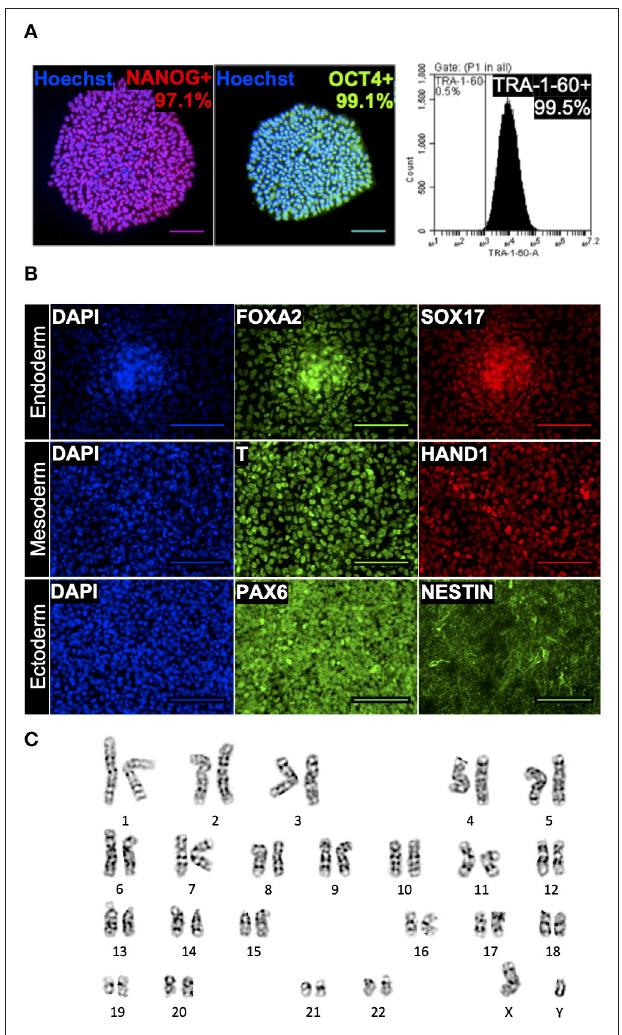
FIGURE 3 | Immunocytochemistry of human induced pluripotent stem cells (hiPSCs) cryopreserved using the optimized dimethyl sulfoxide (DMSO)-free solution. Monochromatic images with pseudo-coloring matching the real color of respective fluorescent dye. (A) Quantitative fluorescent microscopy (counterstained with nuclear dye Hoechst 33342, blue) and forward vs. side scatter-gated flow cytometry of cryopreserved hiPSCs showing high expression of transcription factors NANOG (red), OCT4 (green), and pluripotency surface marker TRA-1-60. Scale bar: 100 µ m. (B) Immunocytochemistry images showing trilineage differentiation of cryopreserved hiPSCs into three germ layers and expression of endodermal markers, FOXA2 and SOX17, mesodermal markers, T and HAND1, and ectodermal markers, PAX6 and NESTIN. Scale bar: 100 µ m. (C) A representative image of normal male karyotype without numerical or structural chromosomal abnormality from the 16 metaphase cells available for